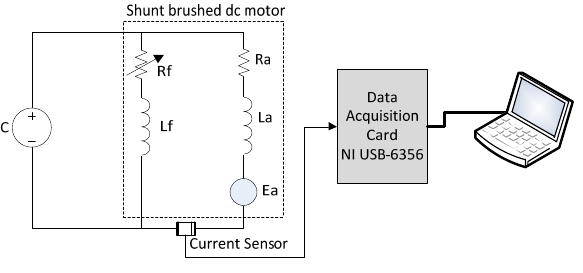
Figure 8. Scheme of the system.